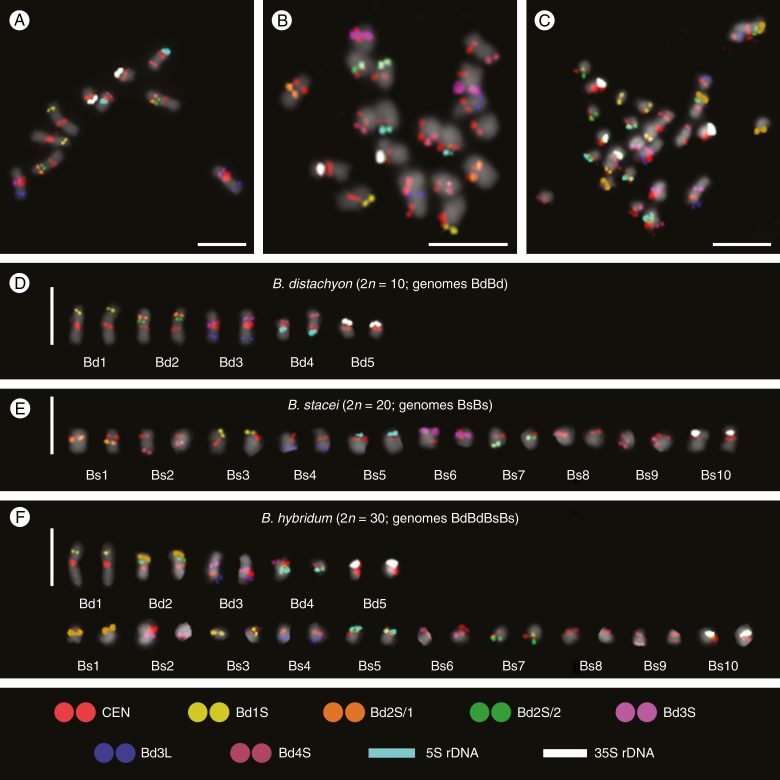
Multicolour FISH identification of B. distachyon Bd21 (A, D), B. stacei ABR114 (B, E) and B. hybridum ABR113 (C, F) somatic metaphase chromosomes using nine probes that were sequentially hybridized to the same preparations. Chromosomes in the karyograms (D, E, F) were extracted from the respective photomicrographs (A, B, C) and ordered according to their total descending length with the 35S rDNA-bearing chromosomes placed at the end, regardless of their length. All of the morphometric chromosome parameters are detailed in Supplementary Data Tables S1–S3. Chromosomes were stained with DAPI (grey). Scale bars = 5 µm.